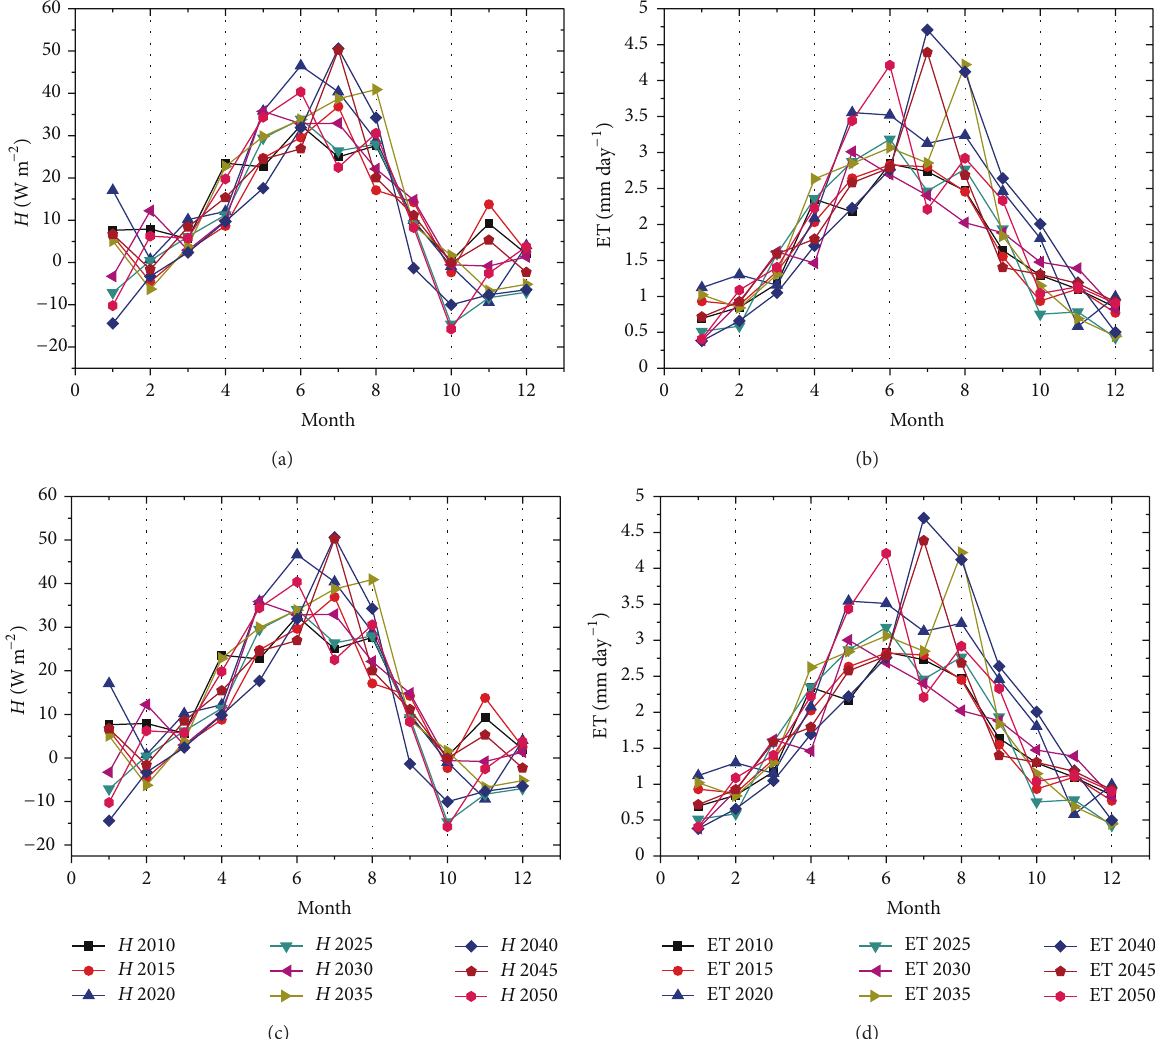
Figure 7: Seasonal variability of H and ET in the next 40 years. (a) and (b) for the simulated results under A2a scenario; (c) and (d) for the simulated results under B2a